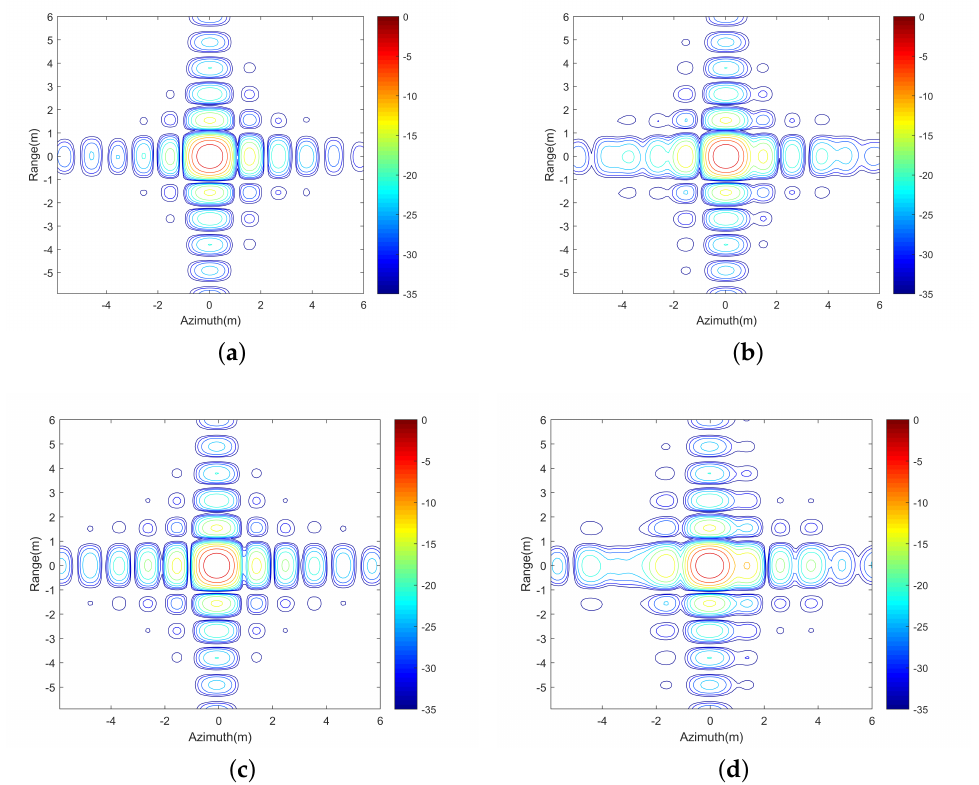
Figure 6. The contour plots of the point target with different errors by IDR (by dB scale). ( a ) with amplitude error; ( b ) with phase error; ( c ) with baseline error; ( d ) with amplitude, phase, and baseline